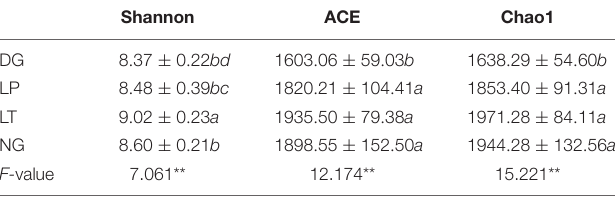
TABLE 1 | Alpha diversity analysis of bacterial in different vegetation restorations.